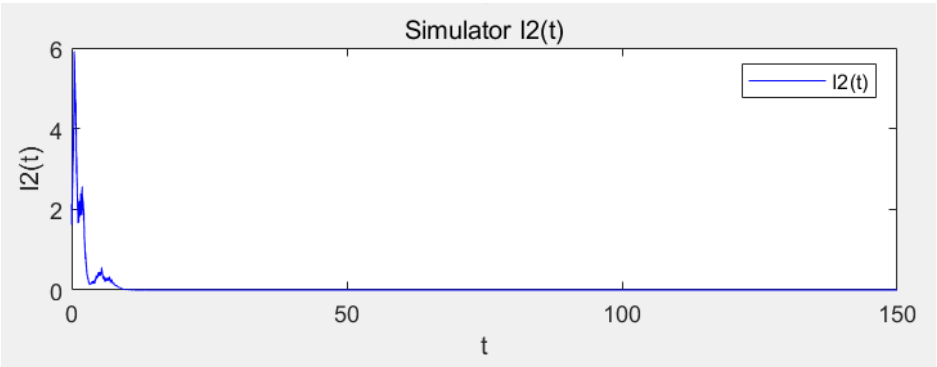
Figure 13. Sample path of